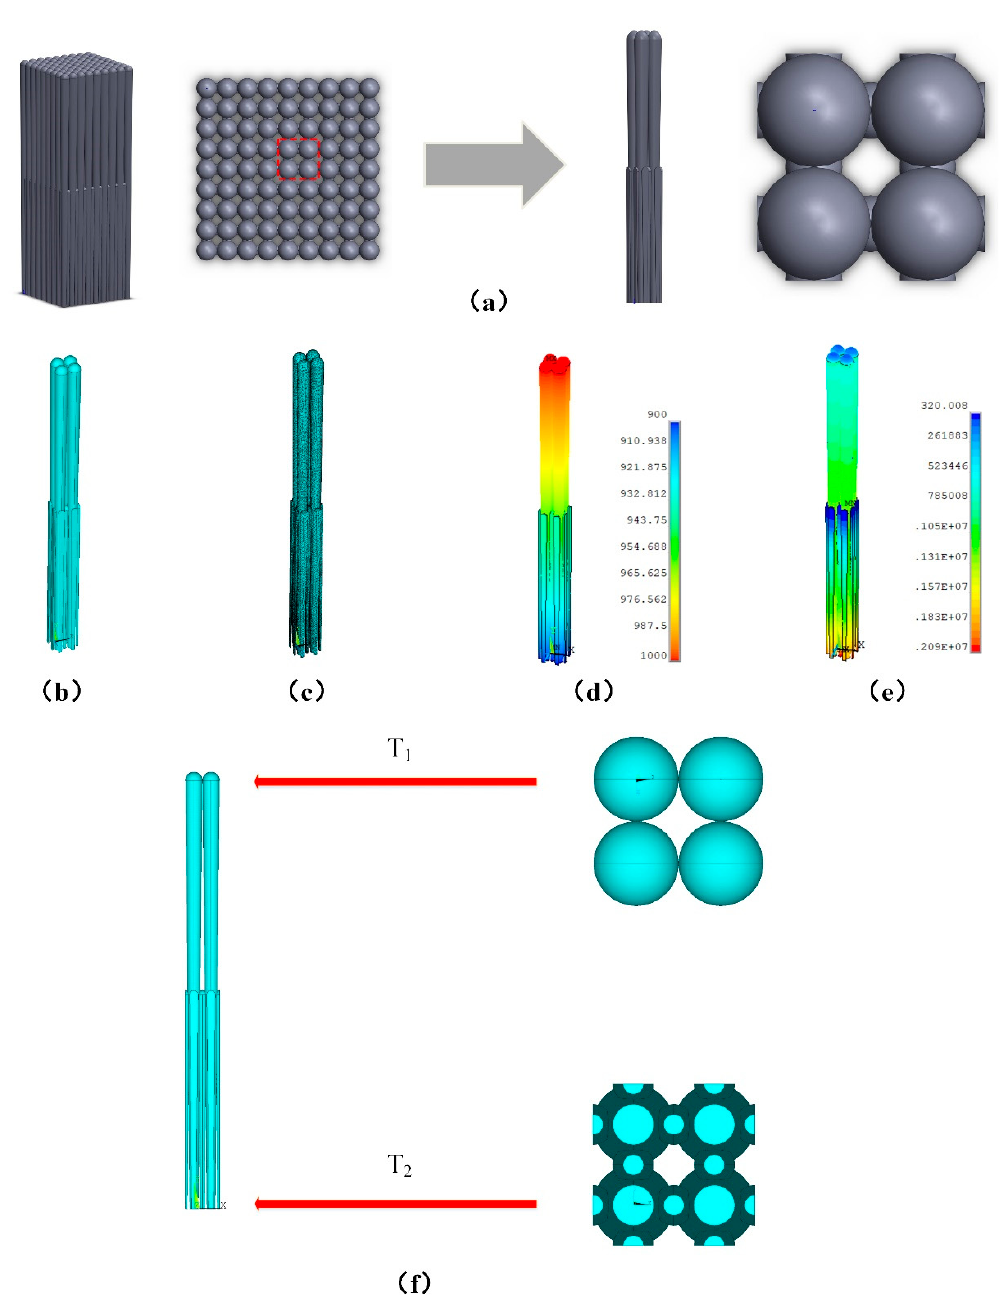
Figure 4. ( a ) Cell model, ( b ) geometric model, ( c ) meshed finite element model, ( d ) temperature contours of the cell model, ( e ) heat flux contours of the cell model and ( f ) boundary conditions of the cell model.